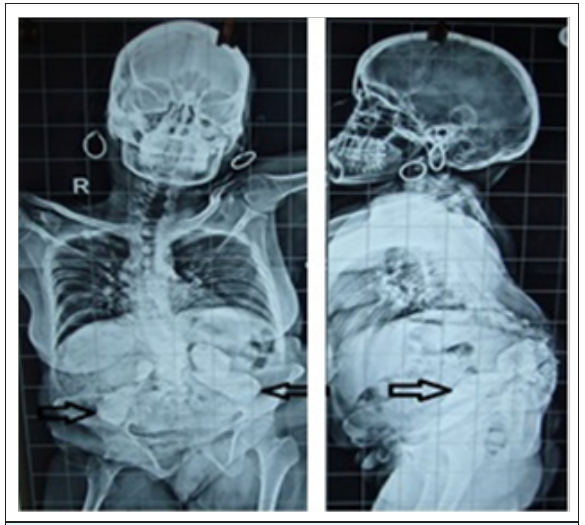
Figure 2. Calcified psoas abscess: AP and lateral views.